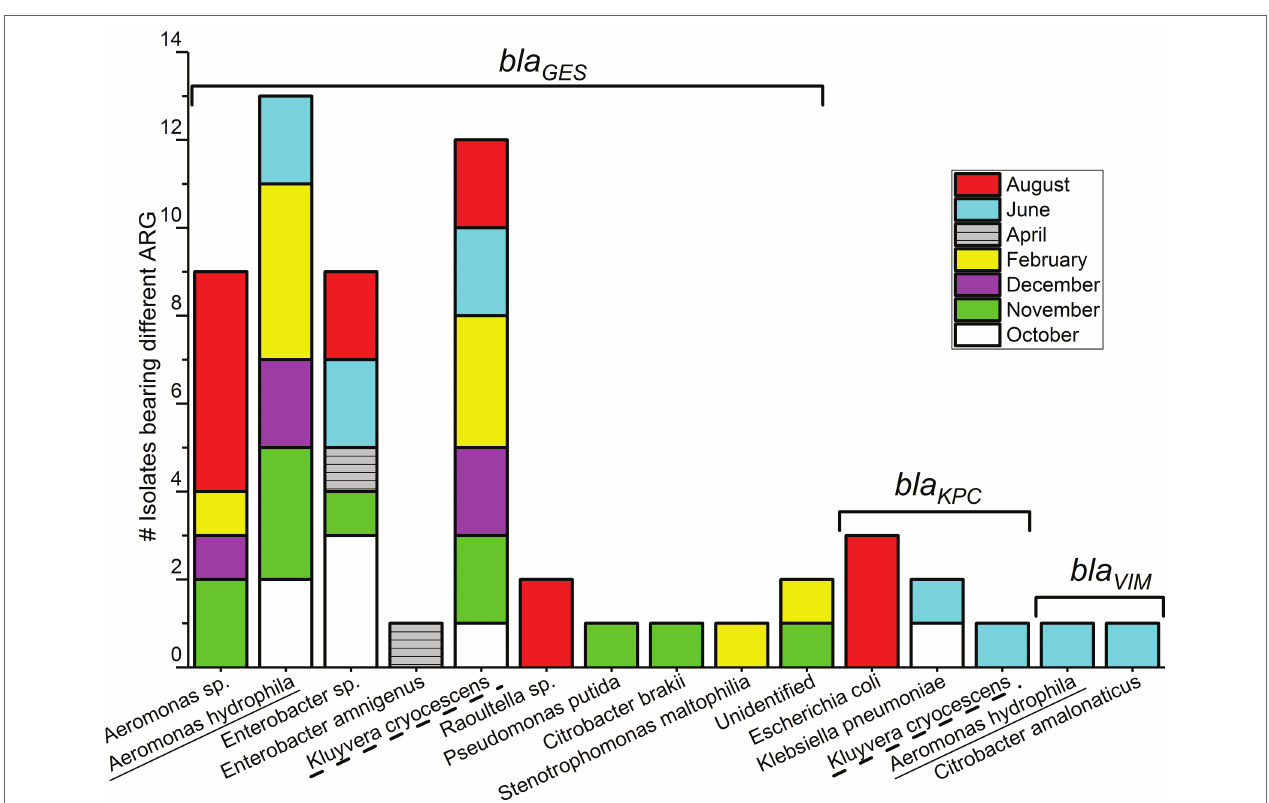
FIGURE 3 | Gram-negative bacterial species carrying bla CARBA genes, isolated from